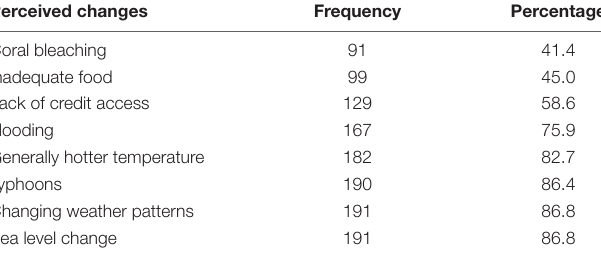
TABLE 2 | Perceived changes in the climate.